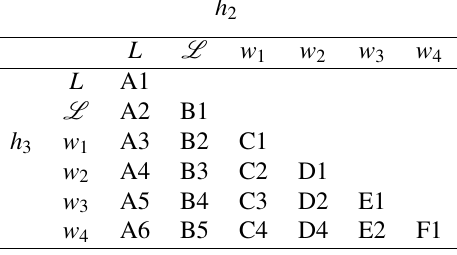
Table 1. Different Cases of Structure of D 2 α ( g ) when h 1 = g ∈ L